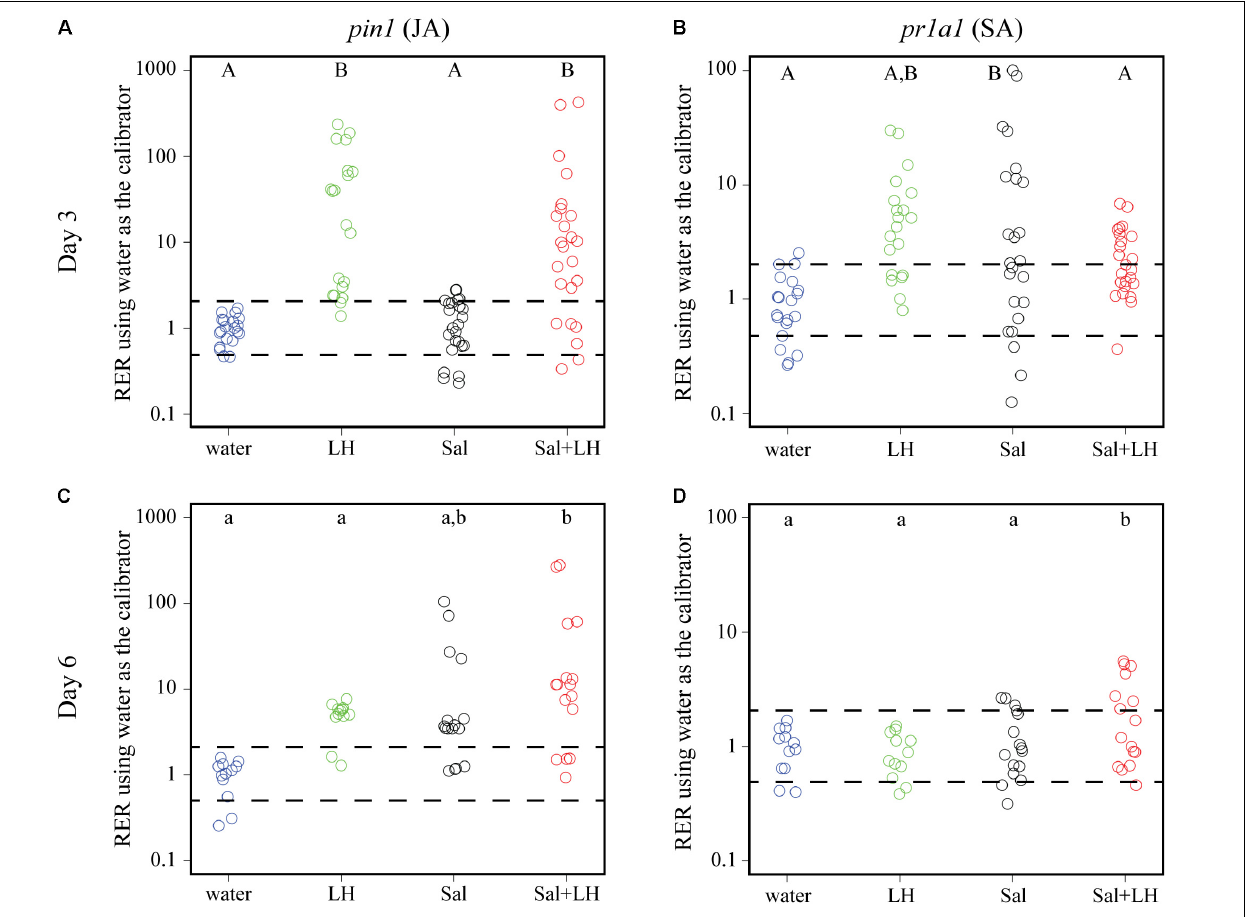
FIGURE 3 | Transcription of plant defense genes changes in response to leafhoppers (LH; green circles), S. Typhimurium bacteria (Sal; black circles), or co-inoculation of bacteria with leafhoppers (Sal+LH; red circles). Plant gene expression was quantified at days 3 (A,B) and 6 (C,D) post-inoculation. Data for the JA-inducible pin1 (A,C) and SA-inducible pr1a1 (B,D) are displayed as relative expression ratios (RER) using transcription in plants treated with water (blue circles) as the negative control and calibrator. The dashed line indicates a twofold change in transcription, and each circle represents data collected from one tomato plant. Transcript levels were quantified from three biological replicates with samples taken from at least four plants per treatment per time point. Letters denote significant differences between treatments within a single time point for that specific plant defense gene ( P <